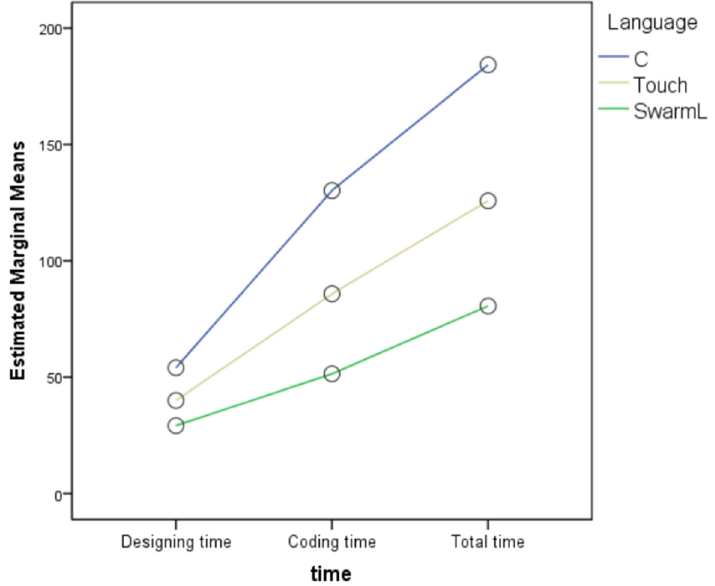
Figure 17. Marginal means of development time for the three groups of programming languages.